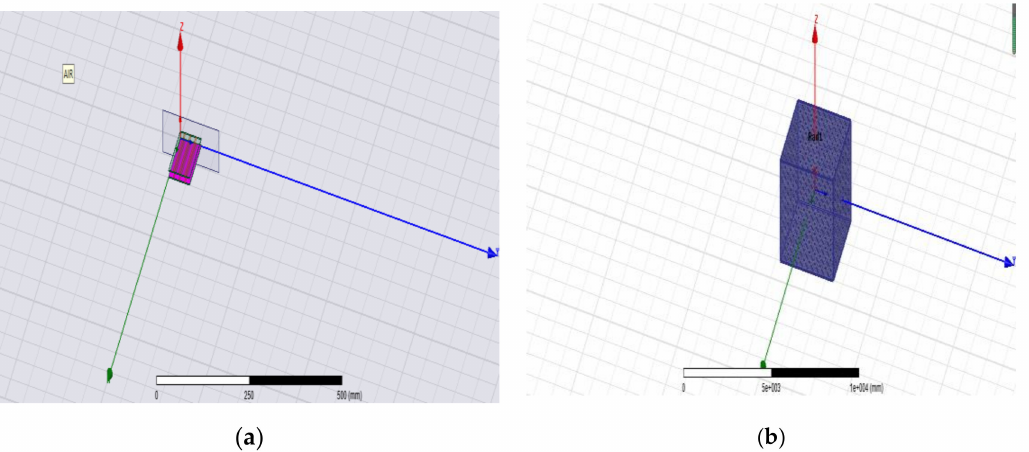
Figure 5. 3D simulation model of the probe. ( a ) Differential probe simulation model. ( b ) Radiative boundary model of differential